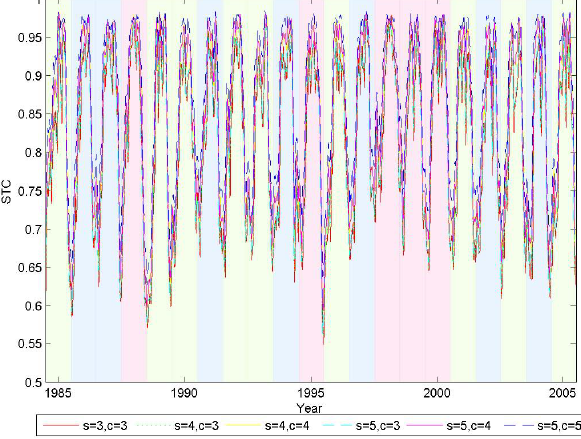
Fig. 4. The STC of the Philippine SST from 1985 to 2005 using different time slice sizes ( s ), different moving cube sizes ( c ) and with a moving window average threshold of 5 weeks (i.e., 2 weeks before and 2 weeks after the week being analyzed). Results with moving window averages of 0, 3, 7, 9, 10 and 11 weeks are similar (Supplement Fig. 1). El Ni˜no years are highlighted in blue, La Ni˜na in red and normal years in